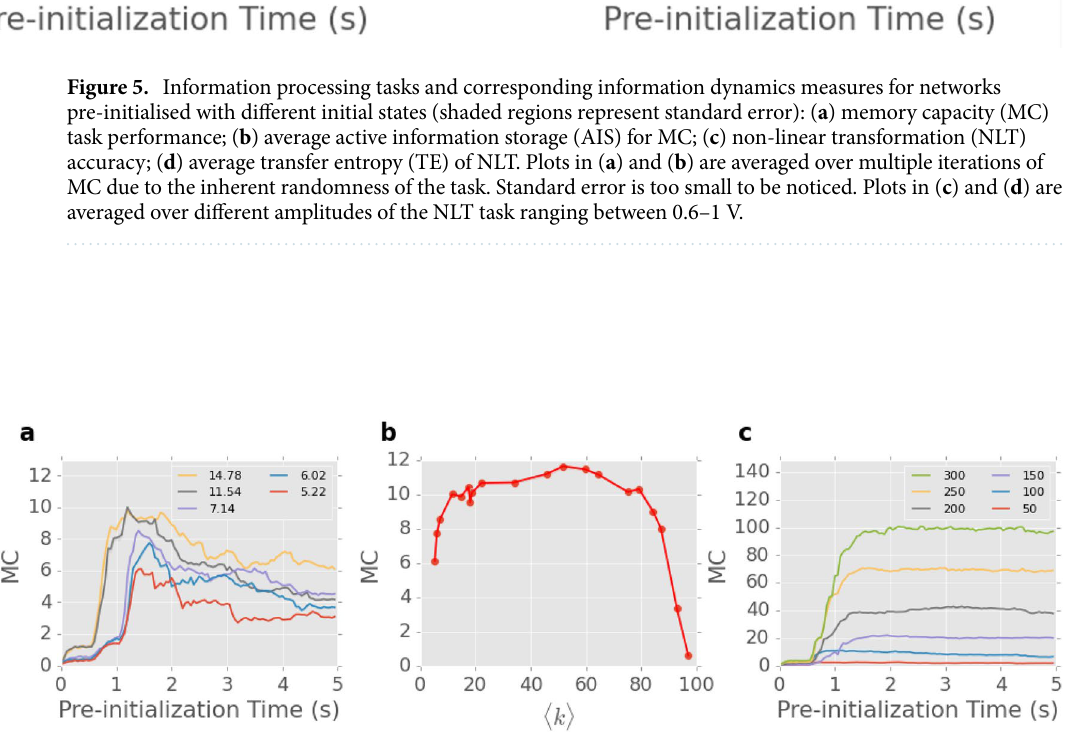
Figure 6. Memory capacity (MC) for networks with varying information processing resources. ( a ) Average MC as a function of pre-initialisation time for 100-node networks with sparse connectivity ( 5.22 ≤ � k � ≤ 14.78 ). ( b ) Maximum MC achieved for 100-node networks as a function of (cid:31) k (cid:30) . ( c ) Average MC vs. pre-initialisation time for networks with different number of nodes (50–300) and similar (cid:31) k (cid:30)